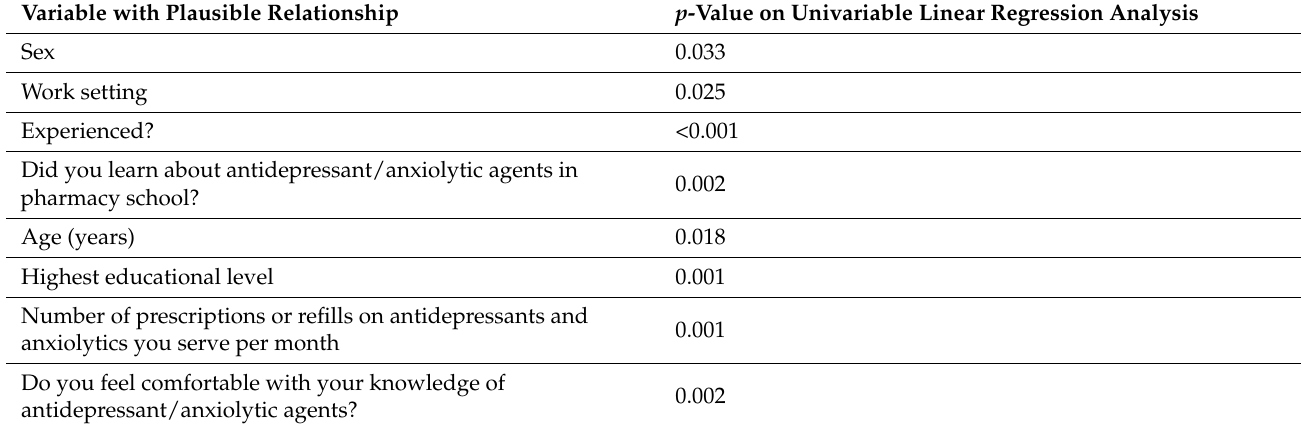
Table 5. Univariate analysis for candidate variables.